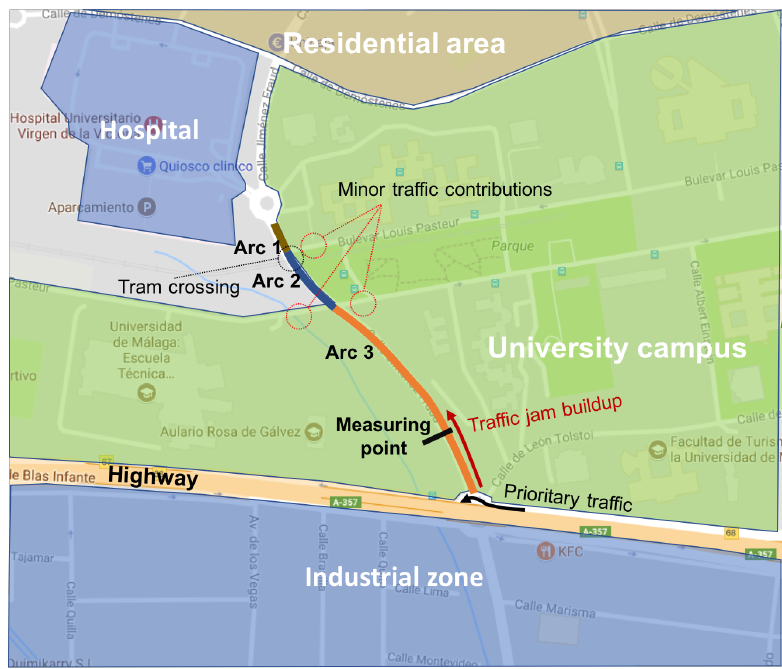
Figure 11. Measurement